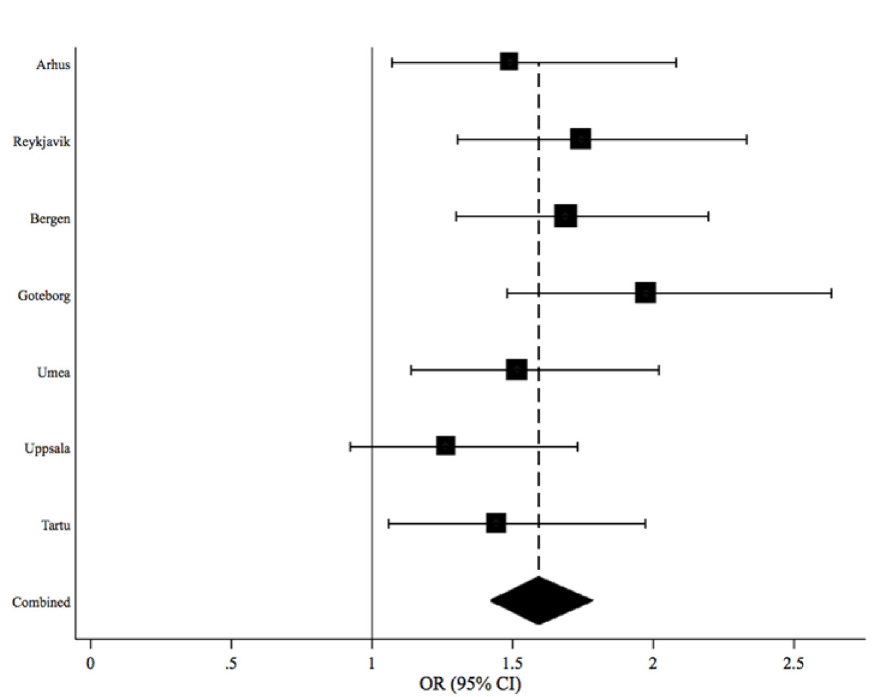
Fig 1. Meta-analysis of the association of (cid:1) 3 asthma symptoms with gum bleeding (sometimes/often/ always vs rarely/never) by study centre, adjusted for age, gender, smoking status and educational level. P heterogeneity = 0.491. Boxes shows odds ratios and horizontal lines show 95% confidence intervals for each study centre, box size is proportional to number of study subjects, diamond shows combined estimate for all centres with 95% confidence